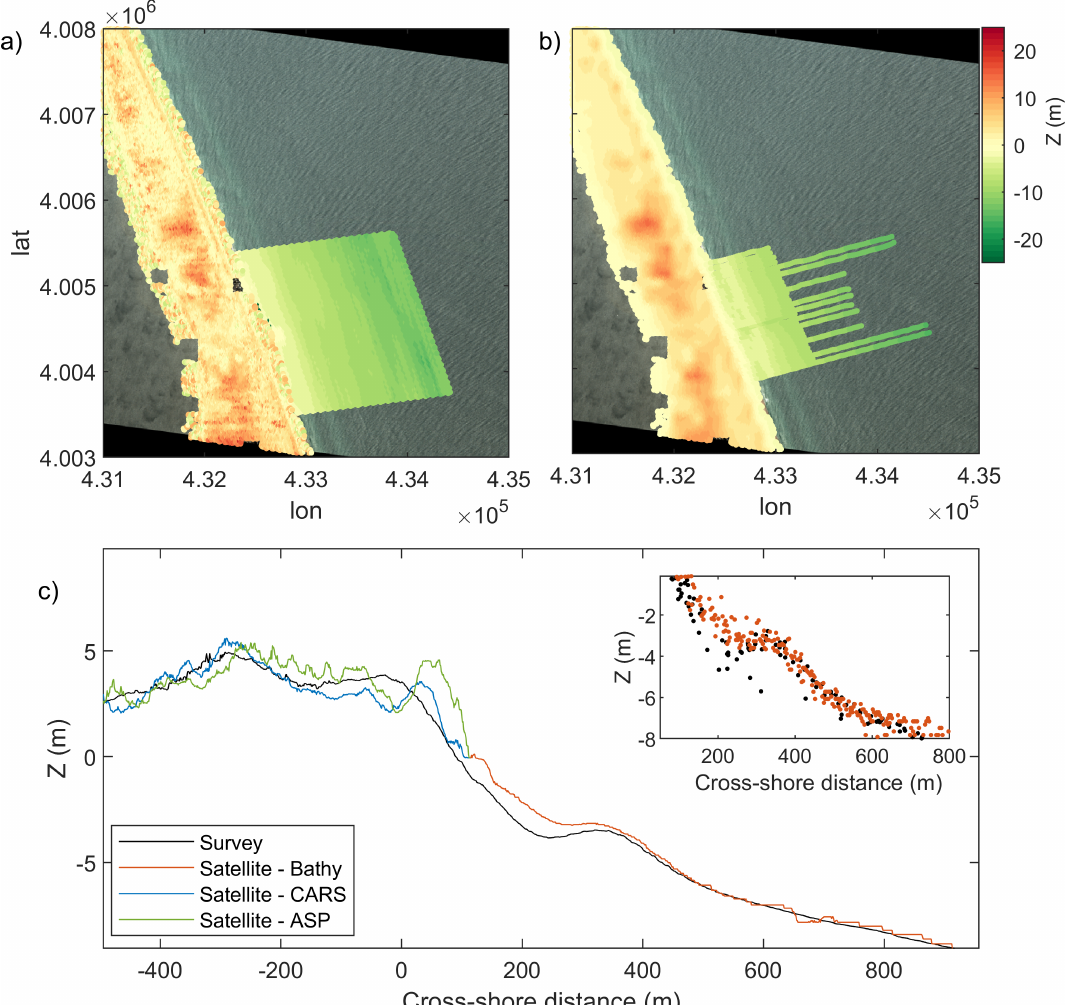
Figure 3. Topography-bathymetry seamless continuum. ( a ) Estimation from satellite (7 June 2020) from CARS for topography and the temporal correlation method for the estimated bathymetry and ( b ) surveyed (23 June 2020) bathymetry with ( c ) a comparison of the alongshore-averaged profile in local cross-alongshore coordinate system (video tower as cross-shore reference and mean sea level in vertical). The inset shows the alongshore dispersion of data points used to compute the alongshore-averaged profile. The profiles are averaged over the alongshore extent of the surveyed bathymetry visible in the panel ( b ). The common vertical datum is the mean sea level. The Jilin video sequence was obtained from CG Satellite in 2020 (Distribution CG), acquired within the framework of a CNES